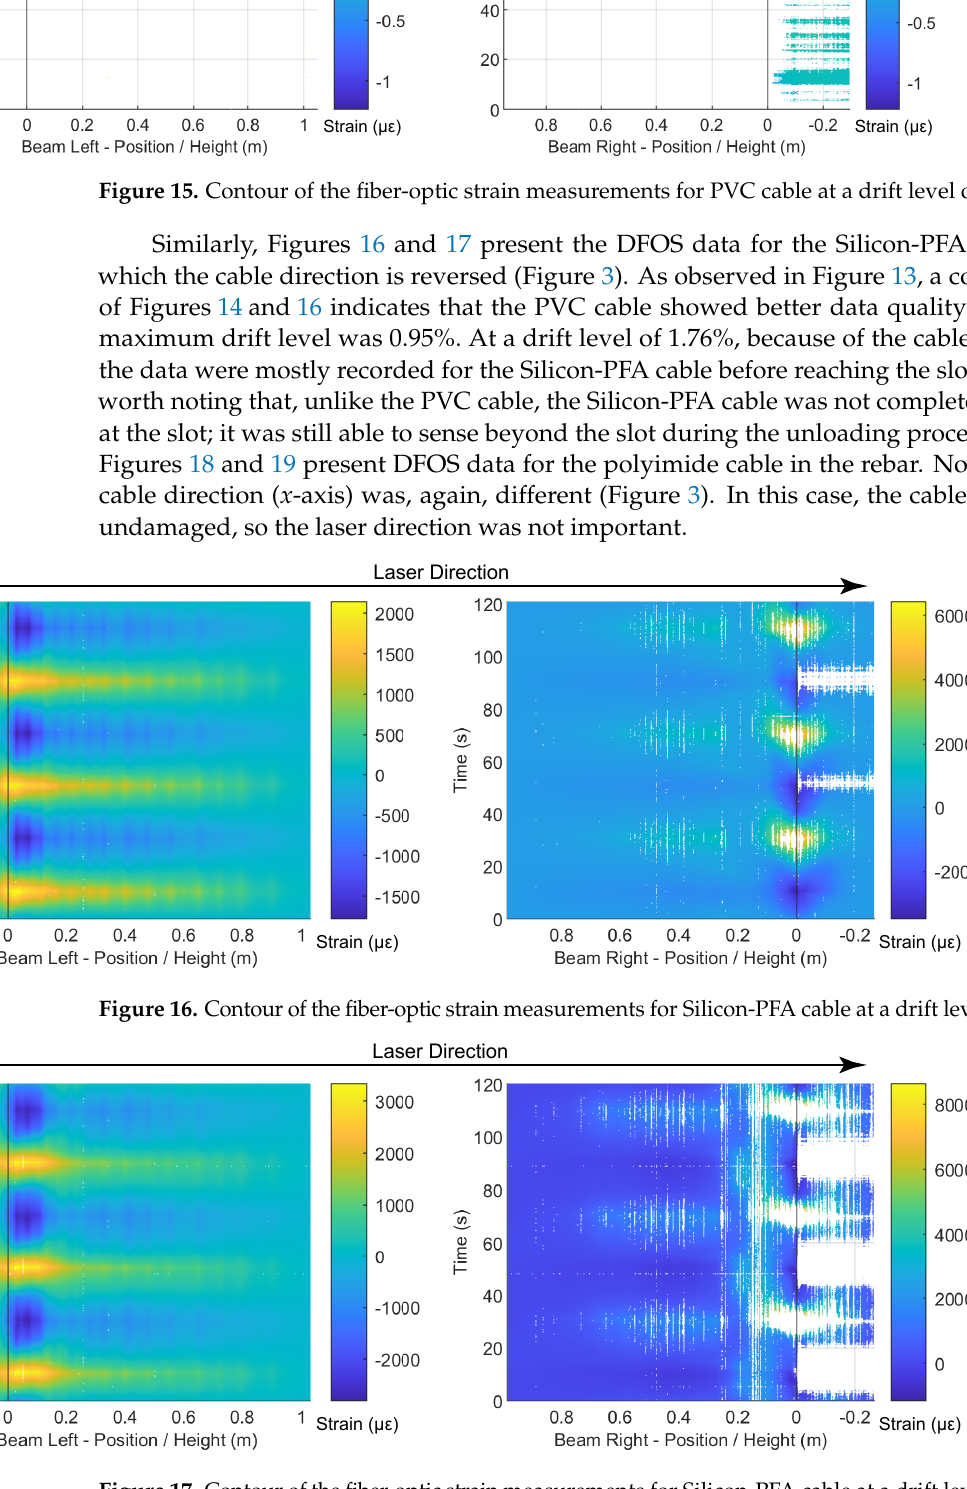
Figure 17. Contour of the fiber-optic strain measurements for Silicon-PFA cable at a drift level of